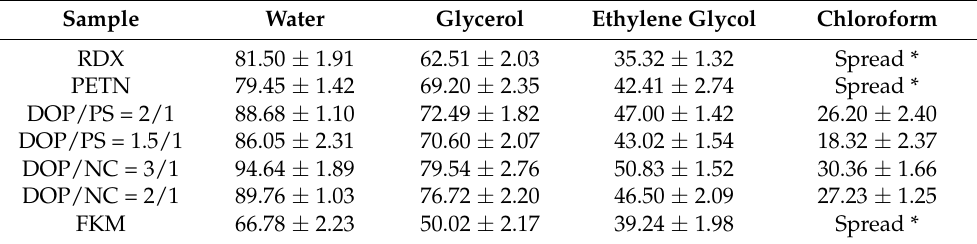
Table 5. The contact angle of energetic material and the